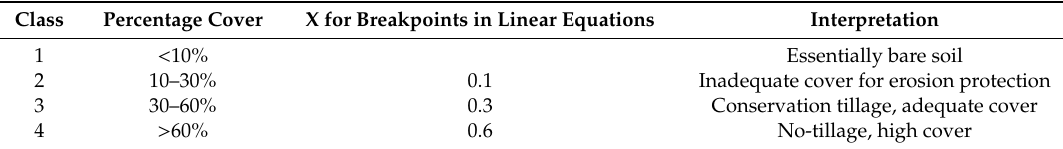
Table 7. Breakpoints in fraction values between common soil cover (e.g., residue and / or green cover) classes.